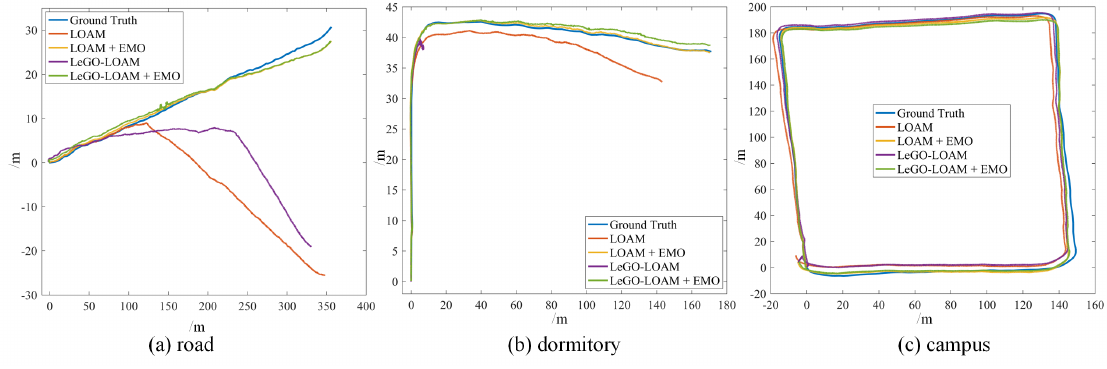
Figure 16. The odometry results of three datasets: straight road ( a ), dormitory park ( b ) and campus ( c